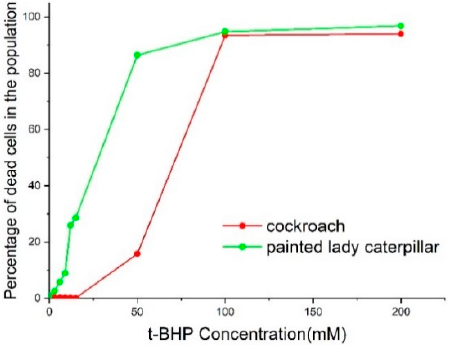
Figure 4. Percentage of the sum of apoptotic and dead cells in cockroach nymph and painted lady caterpillar midguts after six-hour exposure at eight concentrations of t-BHP. Using Annexin V and 7AAD double staining, the percentages of apoptotic cells at three concentrations of t-BHP were obtained (Figures 5 and 6). At concentrations of 12 and 15 mM, t-BHP induced apoptosis in painted lady caterpillar cells (10.9 ± 0.3% at 12 mM and 12.3 ± 1% at 15 mM t-BHP), but almost no apoptosis in Turkestan cockroach cells (0.25 ± 0.08% at both concentrations). At 0 mM t-BHP, the apoptosis was below 0.23% in both species.